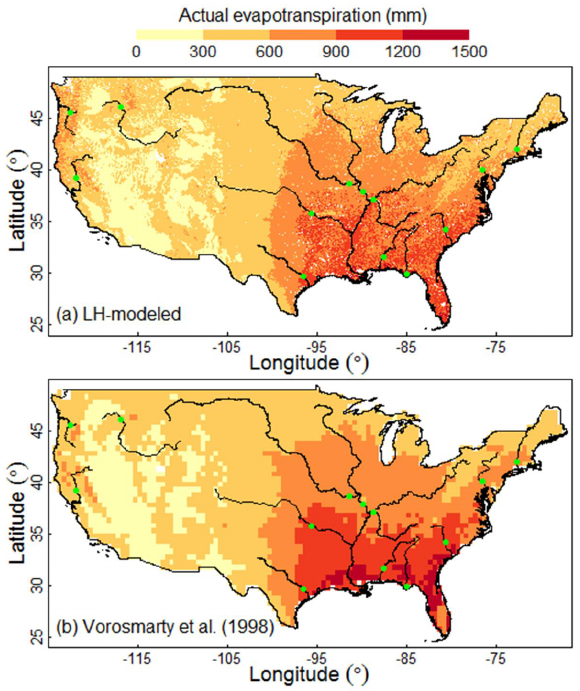
Fig. 2. (a) The LH-simulated 26-yr (1981–2006) average annual actual ET at 2.5 arc-min grid cells; (b) annual actual ET from V¨or¨osmarty et al. (1998) at 0.5-degree grid cells. The white areas in (a) and (b) are water excluded for